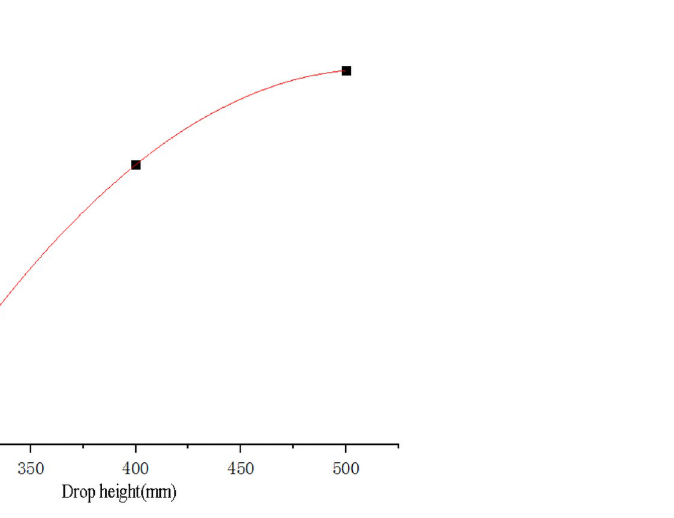
Fig 9. Fitting curve of sweet potato drop height and damage area.